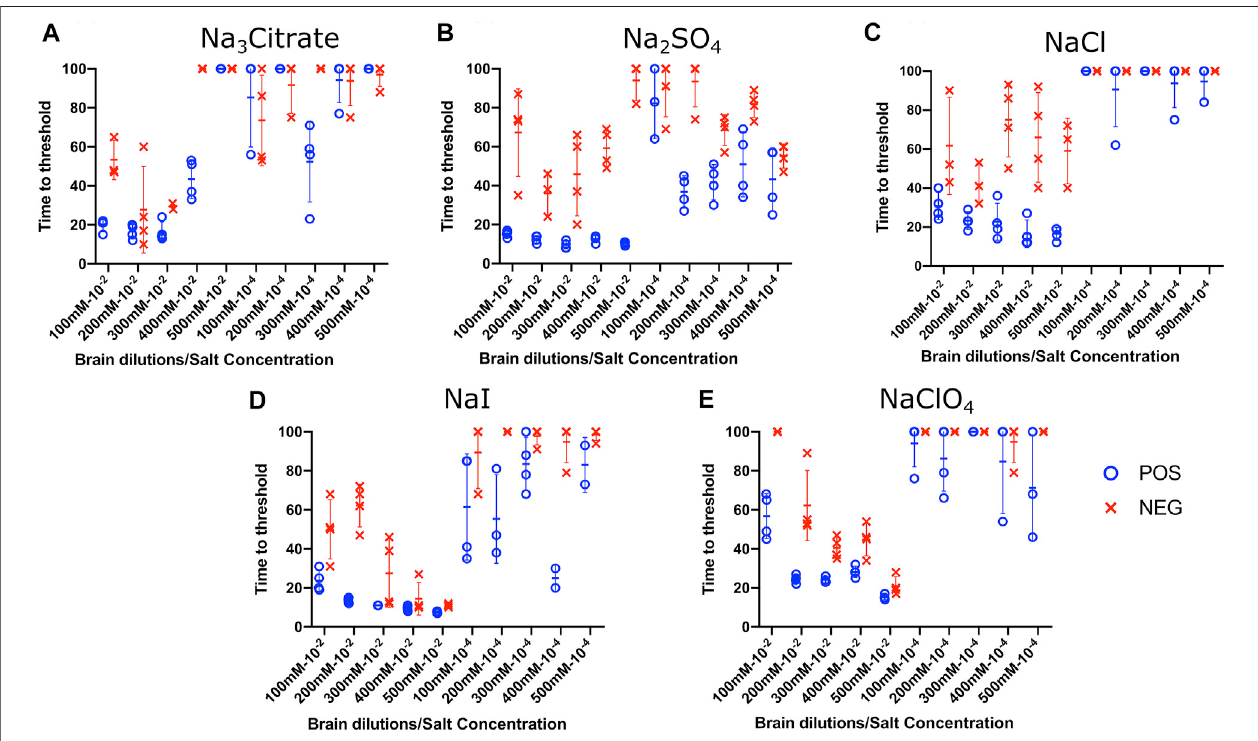
FIGURE 4 | Effect of titration of Hofmeister ions on RT-QuIC reactions seeded with CWD-positive white-tailed deer brains using BV rPrP substrate. RT-QuIC reactions were seeded with 10 − 2 (left side of each graph) and 10 − 4 (right side of each graph) dilutions of the brain homogenate from one CWD-positive and one CWD- negative white-tailed deer with the addition of 0.001% of SDS. Substrate contained BV rPrP and Na 3 citrate (A) , Na 2 SO 4 (B) , NaCl (C) , NaI (D) , or NaClO 4 (E) . The concentration of each salt was tested at 100, 200, 300, 400, and 500 mM. Reactions were run at 42 °